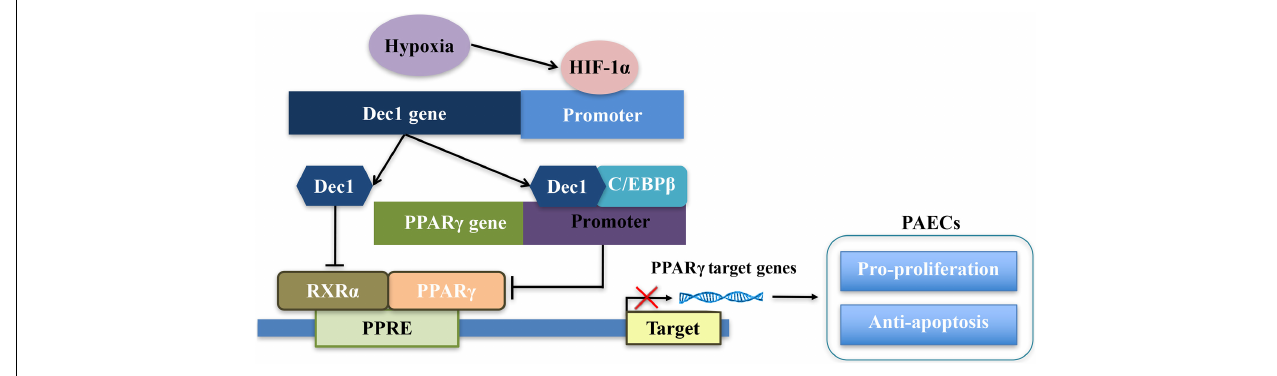
FIGURE 7 | Schema of the signaling pathways leading to disruption of Dec1-PPAR γ axis in PAECs in response to